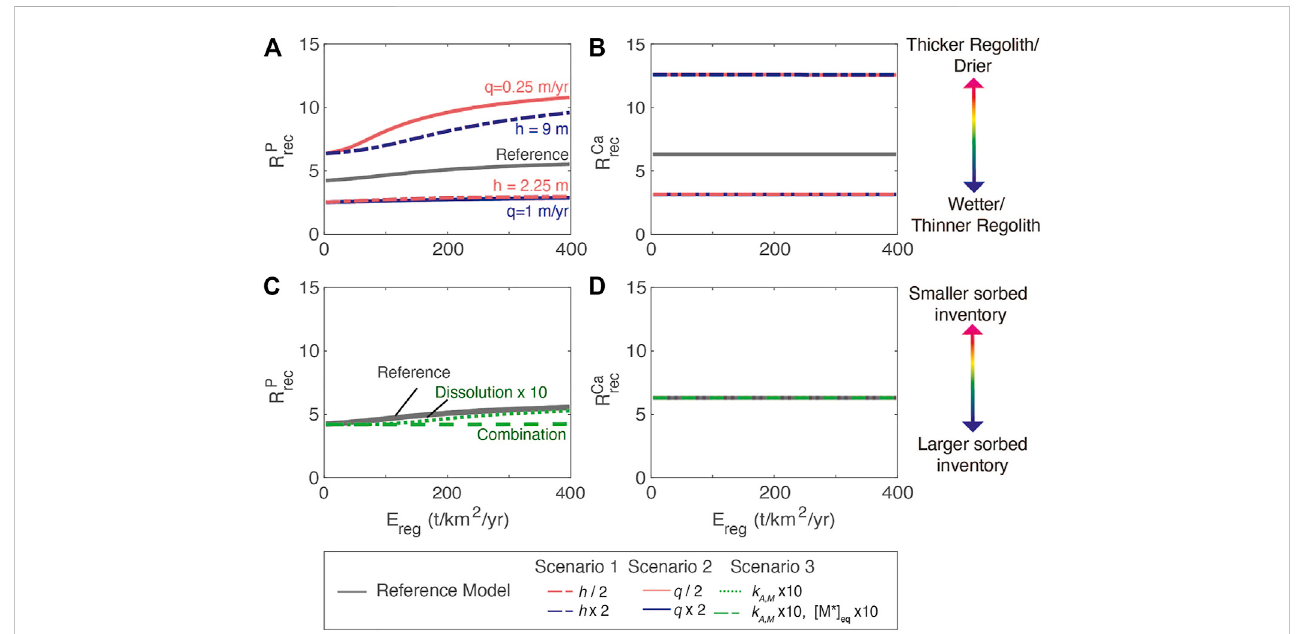
FIGURE 8 (A) Dependenceofphosphorousrecycling, R P rec ,onerosionrateforvariableregoliththickness( h )and fl owrate( q )(scenarios1 – 2) (B) R Ca rec asafunctionof erosion rate for variable h and q (C) dependence of R P rec for biogenic dissolution (scenario 3); (D) R Ca new for scenario 3 (lines